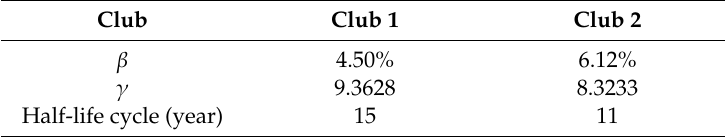
Table 6. Results of the convergence rate and the semi-life cycle in